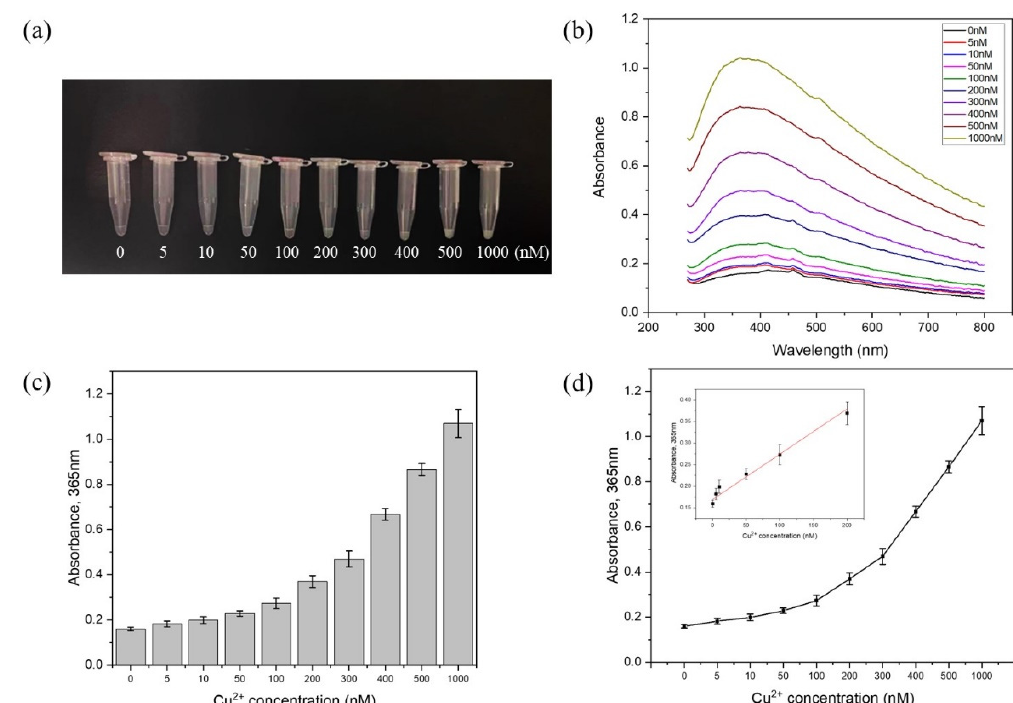
Figure 3. Magnetophoresis assay for Cu 2+ detection. ( a ) Optical image showing the change in the turbidity of the solution from clear to turbid with the increasing concentration of Cu 2+ . ( b ) Absorbance spectrum of solutions under different concentrations of Cu 2+ . ( c ) Absorbance value (mean ± maximum deviation, n = 3) at 365 nm corresponding to ( a ). ( d ) Linear regression of the absorbance value versus Cu 2+